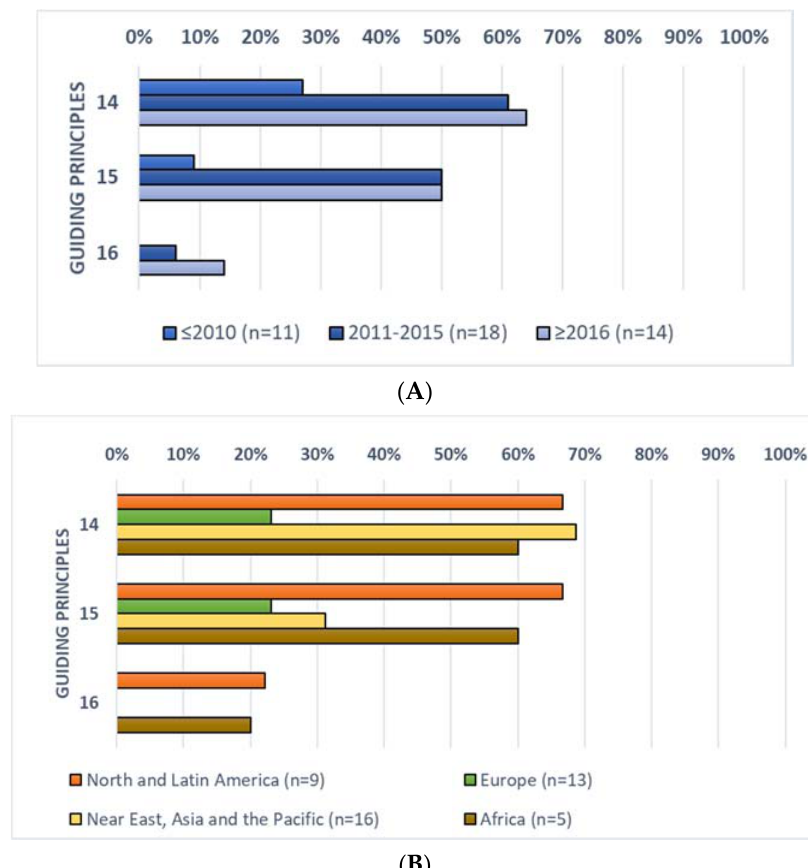
Figure 4. Rate of inclusion of the guiding principles for SHD related to socio-cultural aspects by the 43 FBDGs included in the evaluation, divided by period of publication ( A ) and geographical macro-area ( B ).